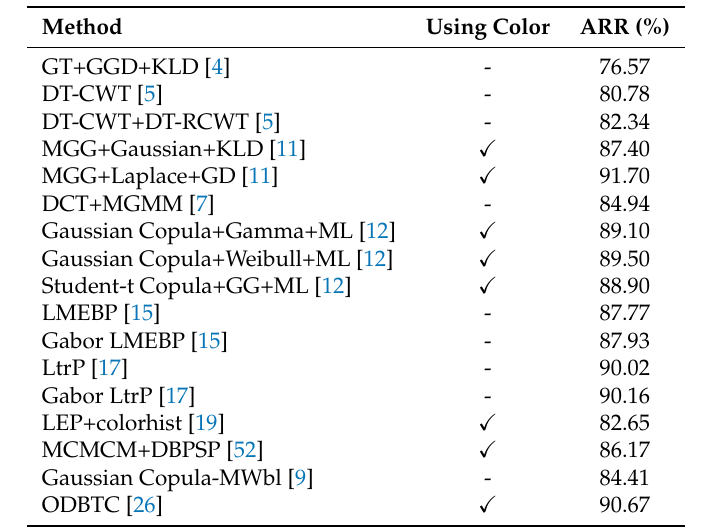
Table 2. Average retrieval rate (ARR) on Vistex-640 database by the proposed method compared to the state-of-the-art